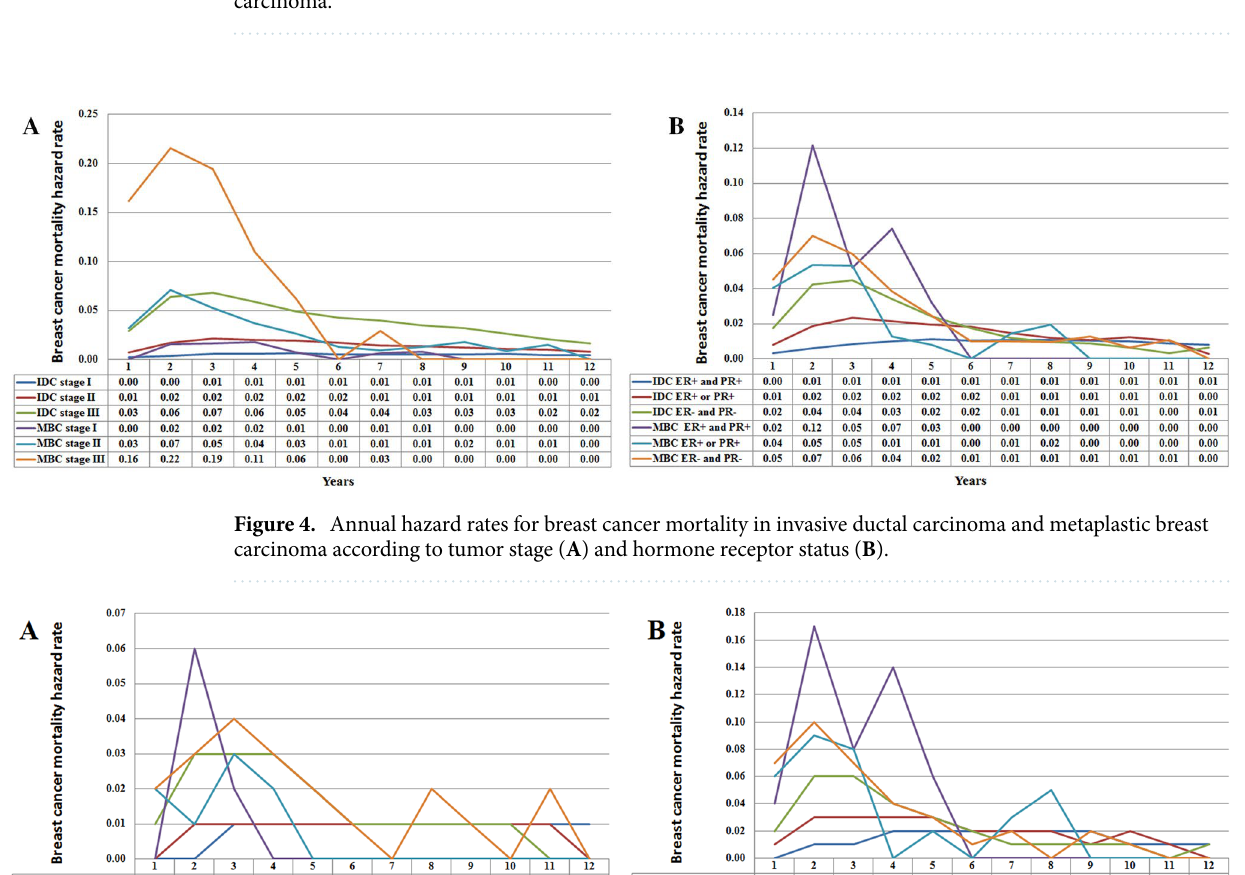
Figure 3. Annual hazard rates for breast cancer mortality in invasive ductal carcinoma and metaplastic breast carcinoma.